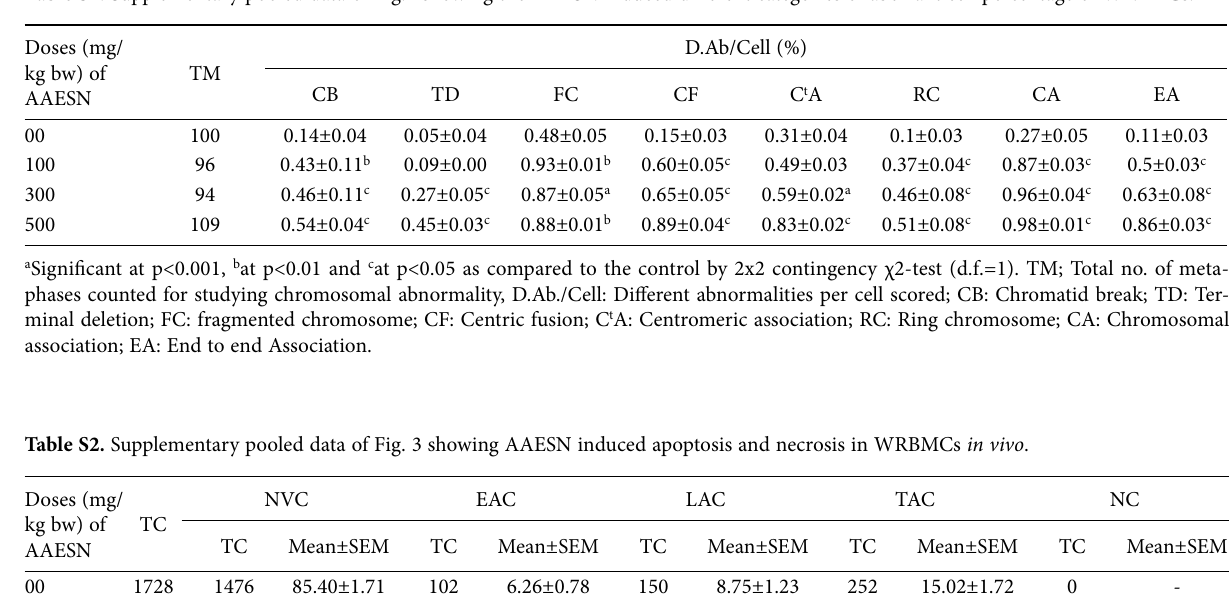
Table S1. Supplementary pooled data of Fig.2 showing the AAESN induced different categories of aberrant cell percentage of WRBMCs.